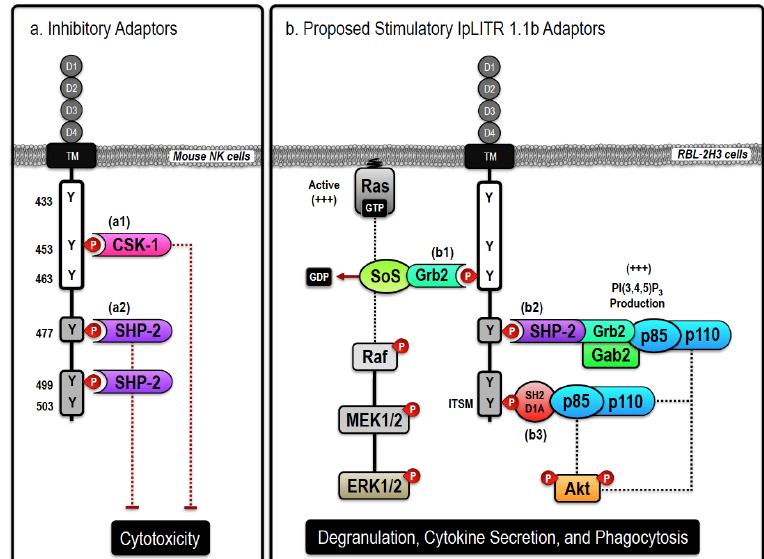
Figure 1. Proposed inhibitory and stimulatory ( Ictalurus punctatus ) leukocyte immune-type receptors (IpLITR) 1.1b-mediated intracellular signaling events. Schematic representation of the proposed inhibitory ( a ) and stimulatory ( b ) signaling events mediated by IpLITR 1.1b in transfected cells. The cytoplasmic tail (CYT) region of IpLITR 1.1b contains six tyrosine residues (Y 433 , Y 453 , Y 463 , Y 477 , Y 499 , and Y 503 ) that, when phosphorylated, serve as potential docking sites for various intracellular signaling adaptors. ( a ) In mouse natural killer (NK) cells, we demonstrated that engagement of IpLITR 1.1b caused a potent inhibition of NK cell-mediated cytotoxicity due to the recruitment of Csk-1 at Y 453 ( a1 ) or the binding of SH2 domain-containing cytoplasmic phosphatases (SHP) at Y 477 and/or Y 499 , which are in immunoreceptor tyrosine-based inhibition motifs (ITIMs) ( a2 ) [64,65]. The immunoreceptor tyrosine-based switch motifs (ITSM) located at Y 503 may also recruit SHP phosphatases but this has not been examined. ( b ) IpLITR 1.1b engagement also induced phosphorylation of ERK1/2